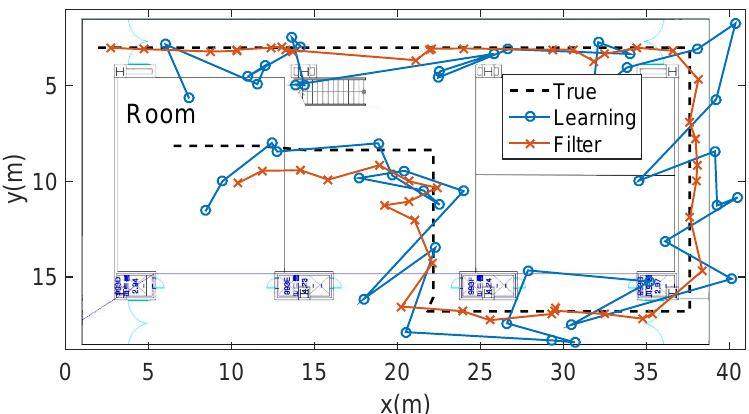
Figure 13. Combination of the particle filter and the learning algorithm, given map information. The test data is obtained through the dotted line. Blue circle line is the result when using only learning localization. Red cross line is the result when we combine the learning with the filter, illustrating a smoother and more accurate